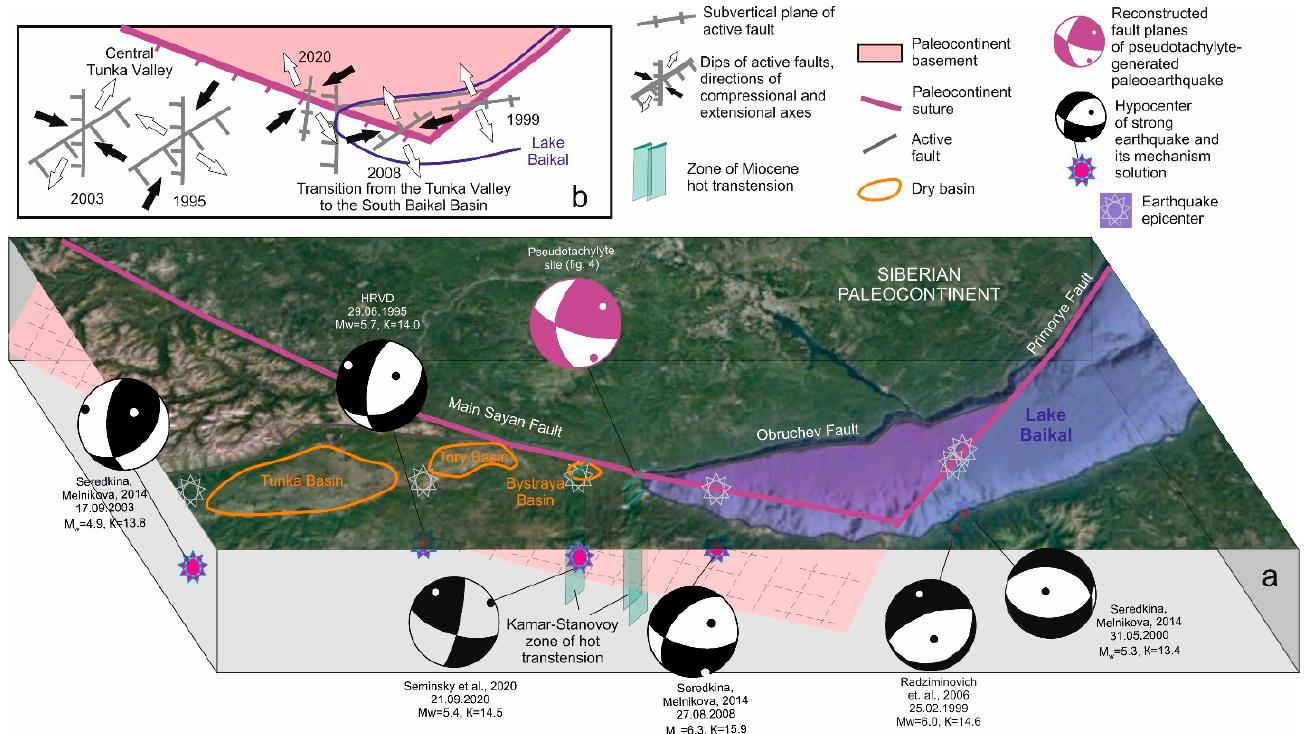
Figure 19. Schematic block-diagram of the Tunka Valley and South Baikal Basin for comparison between the fault planes Scheme 3. and the nodal planes, reconstructed from focal mechanism solutions of earthquakes in seismically active faults ( a ) and schematic change in compression and extension forces in active faults of the Tunka Valley and South Baikal Basin ( b ). Focal mechanism solutions of strong earthquakes are shown after [56,127–129].